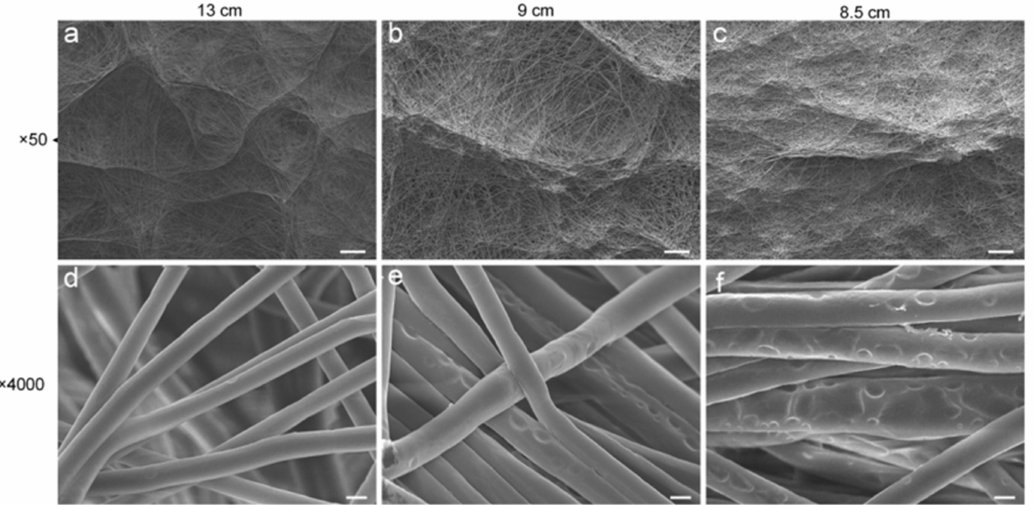
Figure 5. SEM images at different collecting distances during cryogenic e-spinning in high humidity ( a – f ). The receiving temperature was − 10 ◦ C and the ambient humidity was 70%. Scale bars are 200 µ m ( a – c ) and 2 µ m ( d – f